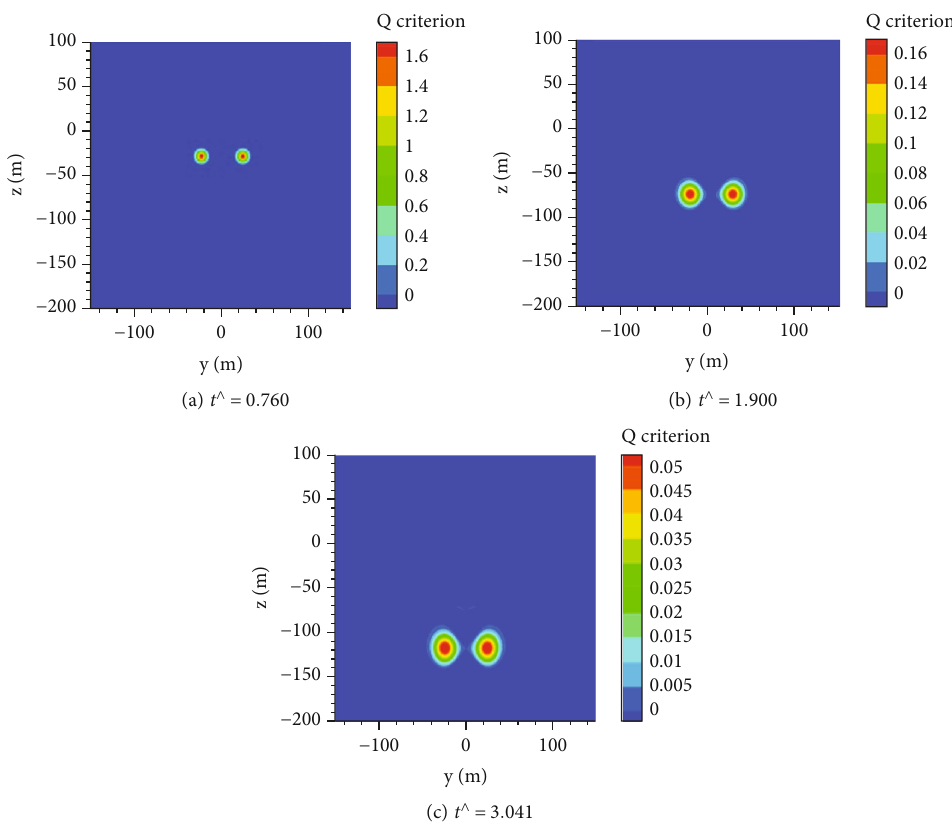
Figure 13: Contours of Q criterion at di ff erent times when there is no